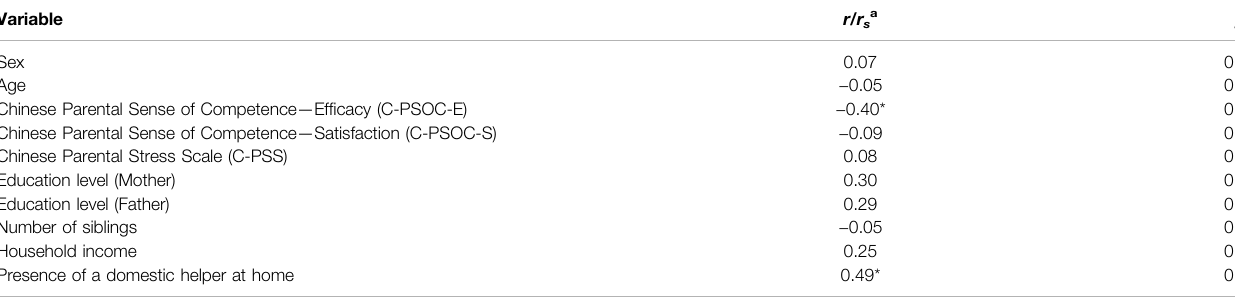
TABLE 3 | Correlations of different variables with CSBS scores at time 2 in HMTW group. Variable